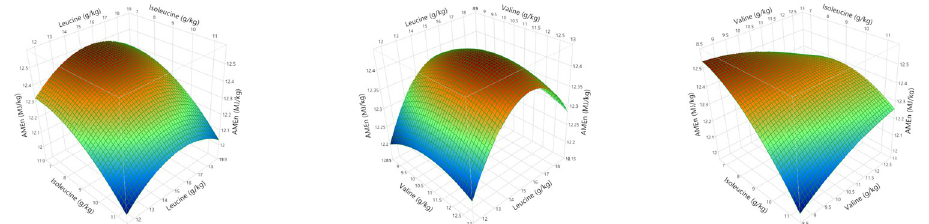
Fig 7. Response surfaces showing the relationship between nitrogen corrected apparent metabolisable energy (AME n ) and dietary digestible branched chain amino acids in male broilers from 24 to 28 days post-hatch where the maximum AMEn (12.42 MJ/kg) could be estimated at 15.74 g/kg digestible leucine.